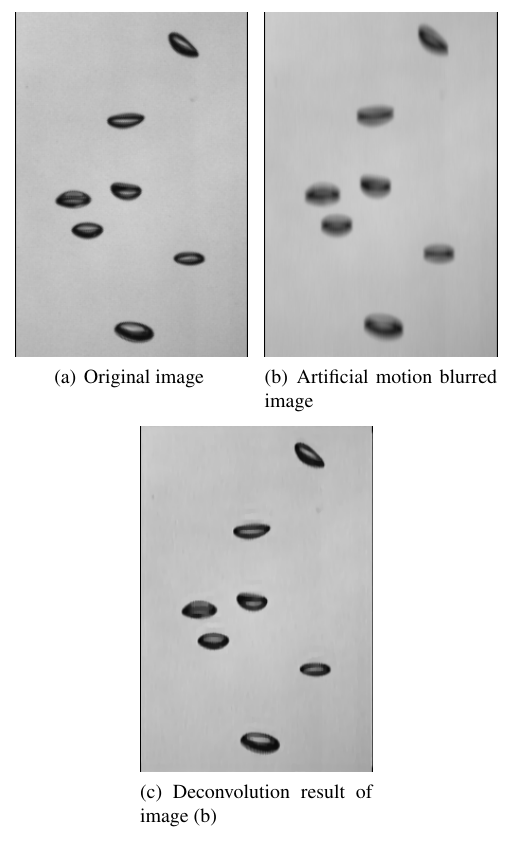
Figure 9: Comparison between original, blurred image and gradi- ent sparsity MAP deconvolution result for gas bubbles with 6mm diameter in a bubble box with back illumination. This demon- strates the accuracy of the